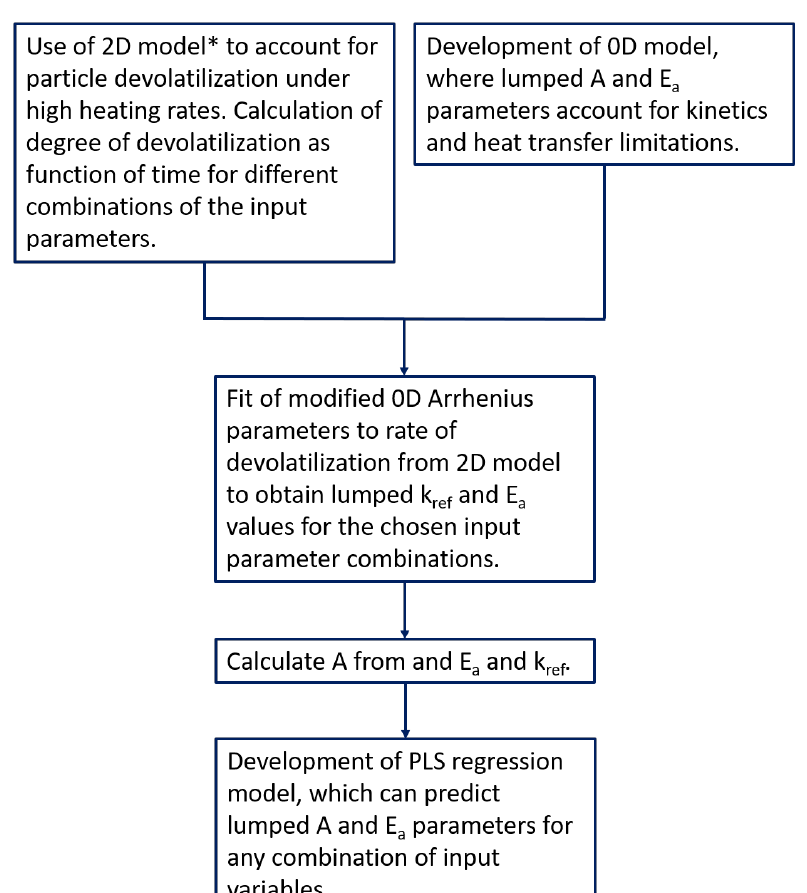
Figure 1. Sketch of model development process. * Semi-2D model development described else- where